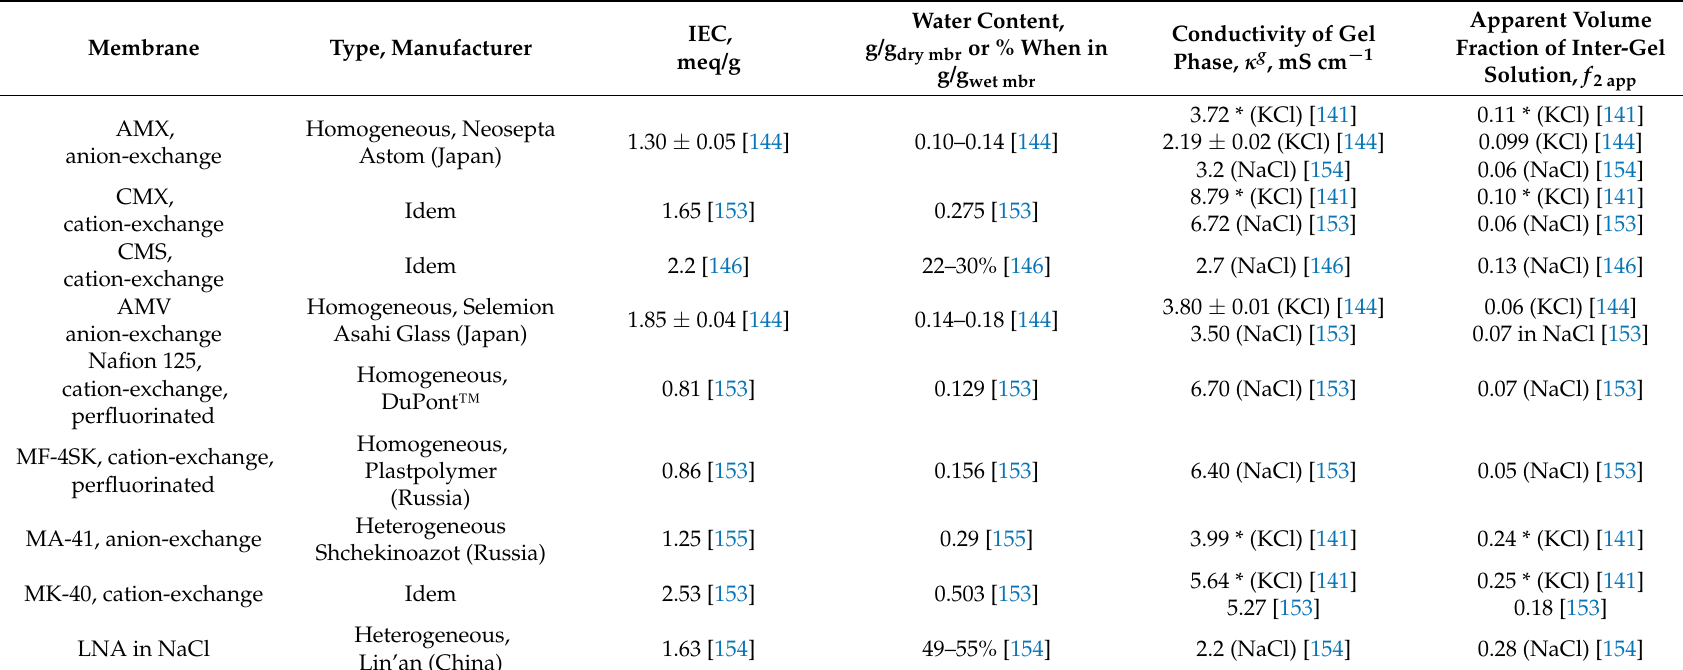
Table 1. Properties of some homogeneous and heterogeneous ion-exchange membranes (IEMs) in NaCl or KCl solutions. Conductivity was measured under alternative